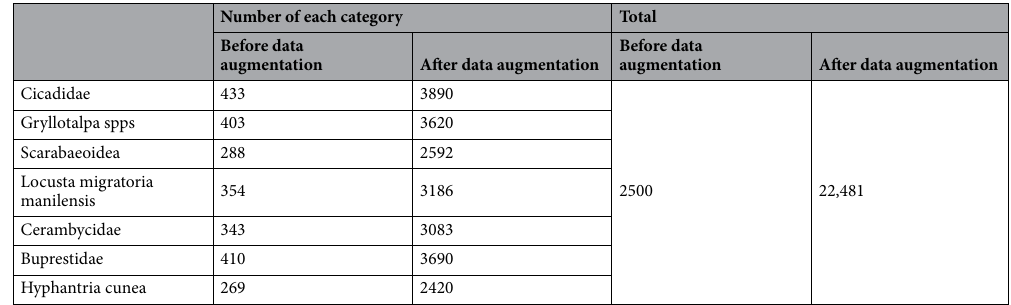
Table 1. Statistics of PestImgData-1.